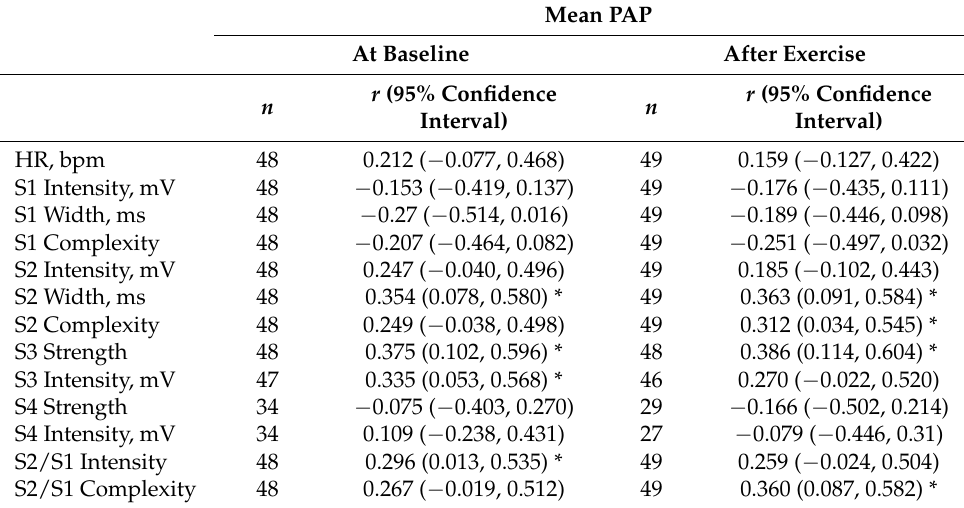
Table 3. Correlation between absolute values of PAP and CABs.